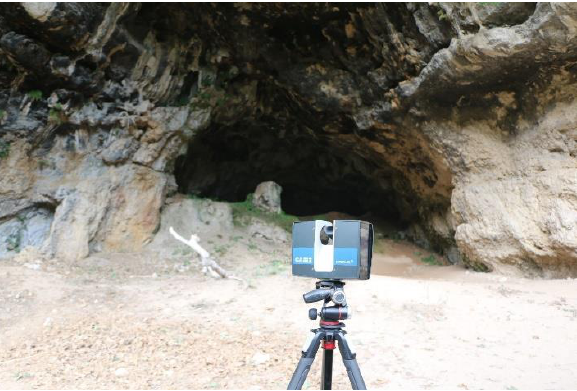
Figure 4. Antrum of the cave. Picture by D. Marturano programme started to identify the species and to estimate the number of specimens and their seasonality. The following taxa were observed: Rhinolophus ferrumequinum, R. euryale,